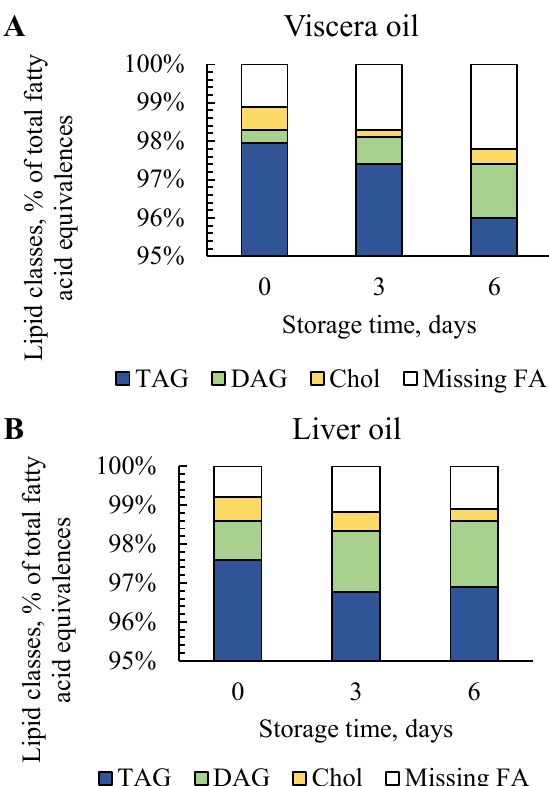
Figure 2. Lipid classes presented as fatty acid equivalences (% of total fatty acids) obtained from 1 H NMR analysis in ( A ) viscera oil and ( B ) liver oil.